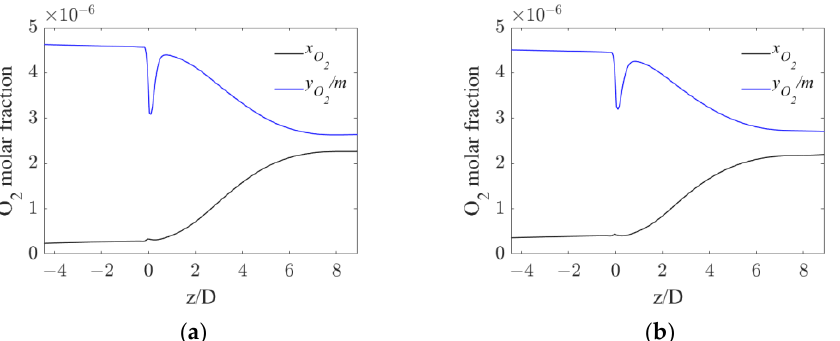
Figure 8. Axial profiles of oxygen mole fraction in water and equilibrium oxygen mole fraction for the operative conditions considered: ( a ) Q L = 25 m 3 /h and Q G = 3.75 L/min; ( b ) Q L = 30 m 3 /h and Q G = 7.5 L/min. The initial and final part of the pipe are omitted to improve readability.